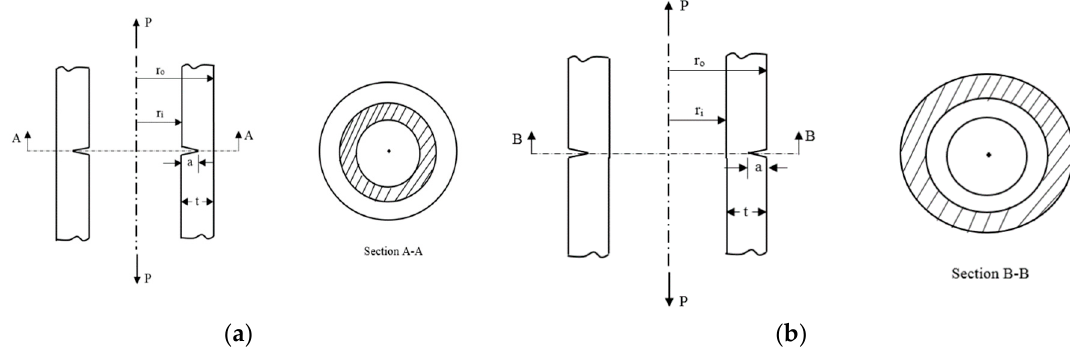
Figure 2. Schematic representation of ( a ) internal and ( b ) external circumferential through-wall cracks